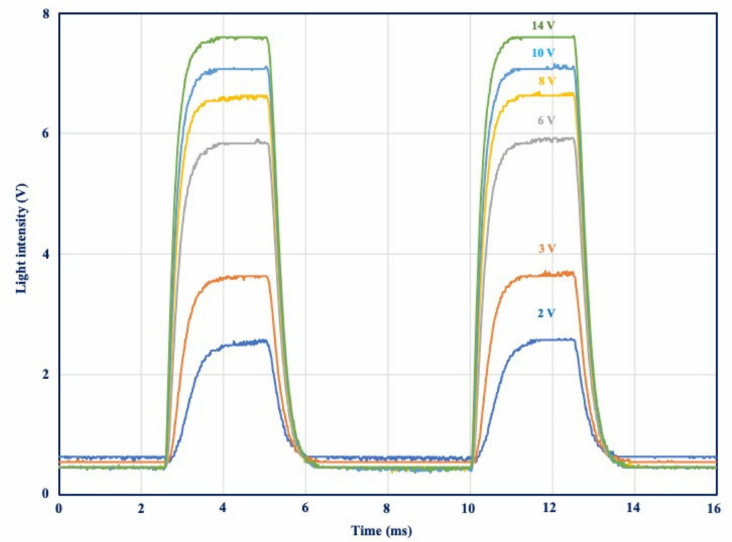
Figure 7. Applied pulse voltage dependence of light throughput of the expectedly uniform stacked SSD-LC panel. Applied pulse voltage is a bipolar pulse having a 3 ms duration with a 5 ms zero voltage